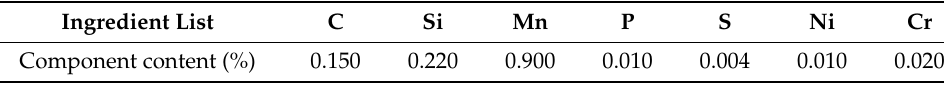
Table 2. Chemical compositions of the target material.